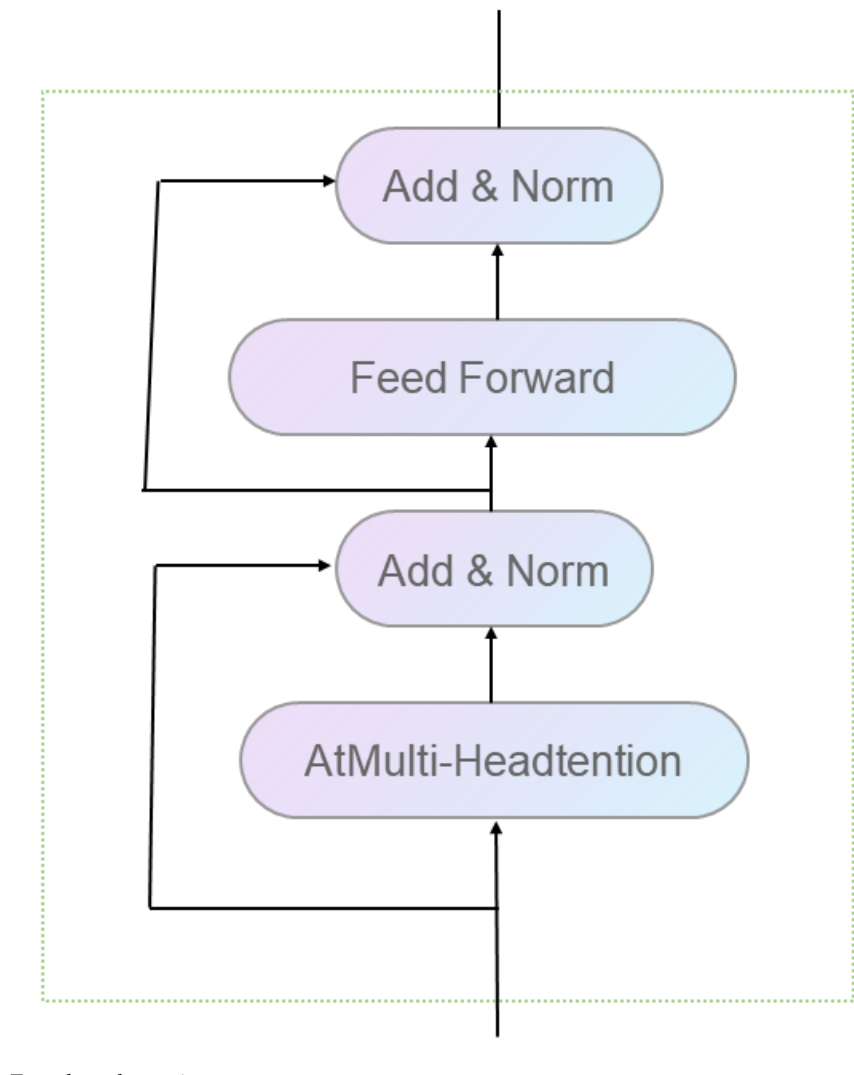
Figure 2. Encoder